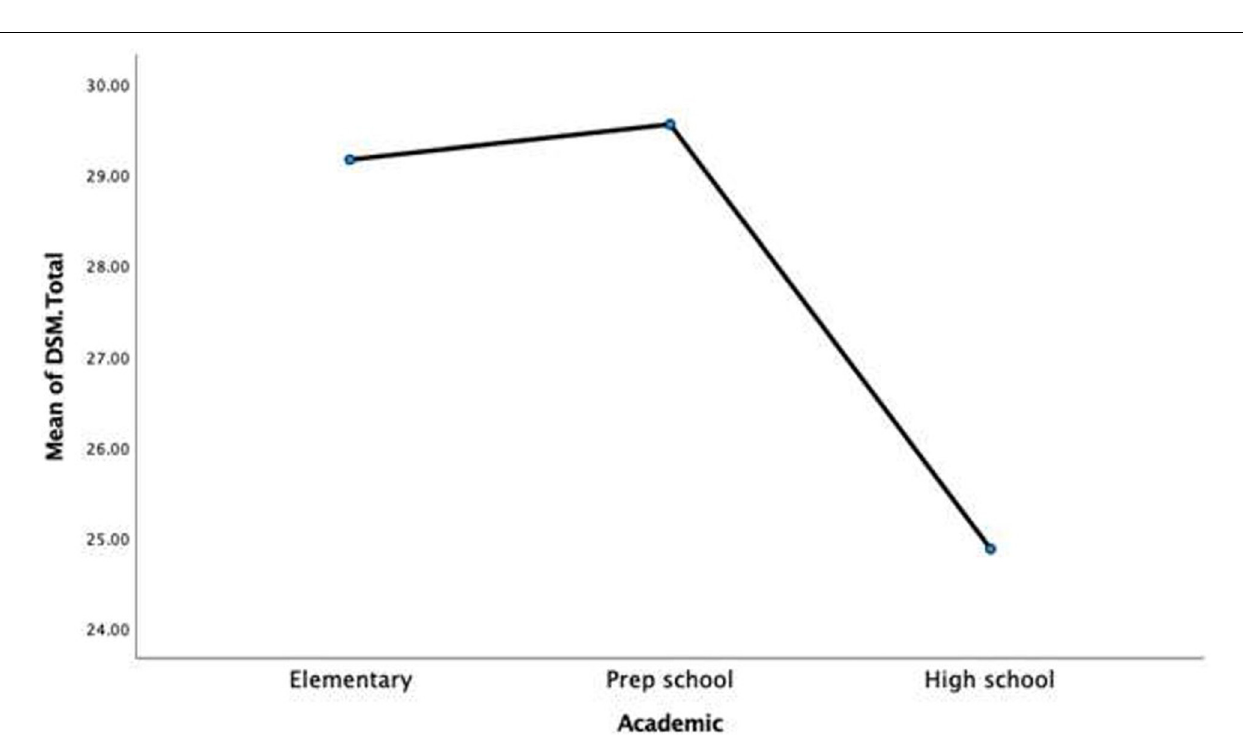
Frontiers in Psychiatry |